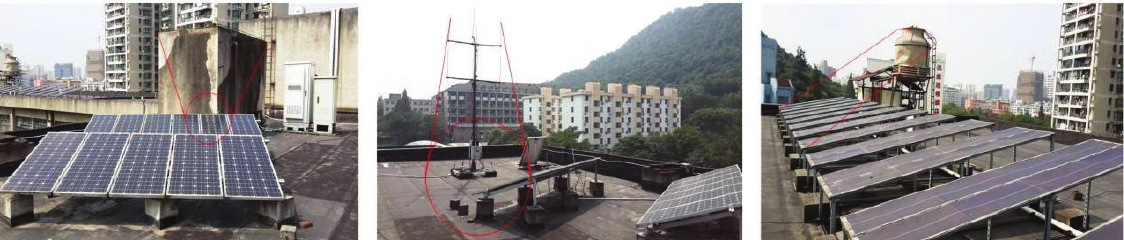
Figure 6: Roof top PV system installed at ZJU.